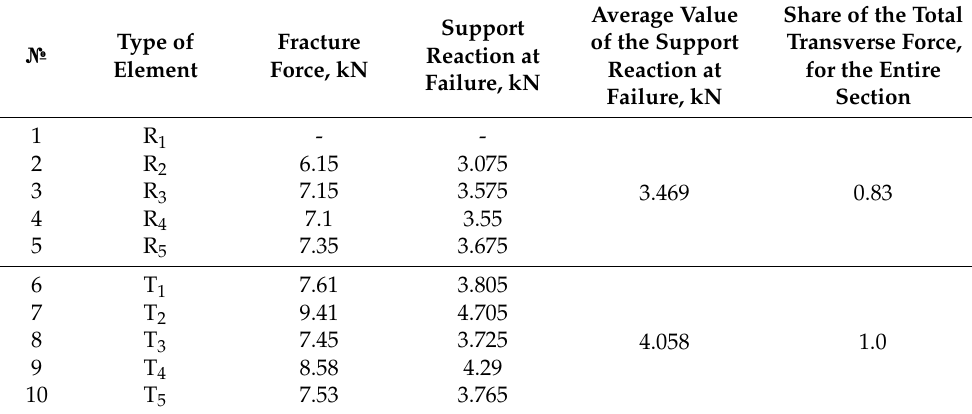
Table 3. Summary table of experimental results.